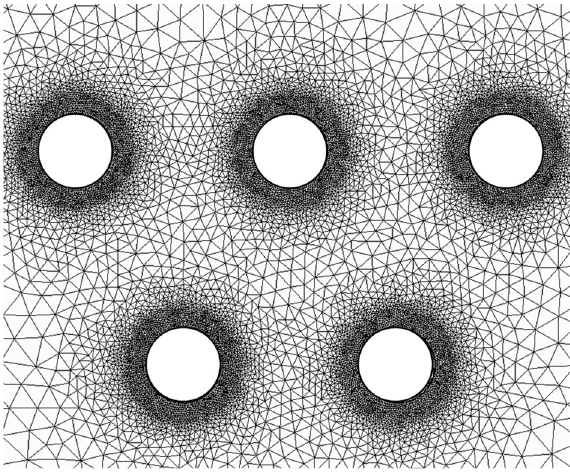
Figure 2. A zoom-in view of the meshes around vegetation cylinders for staggered